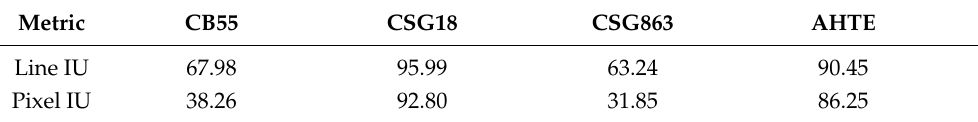
Table 4. Diva evaluator results of MRCNN extraction with disconnected bounding polygons on DIVA and VML-AHTE